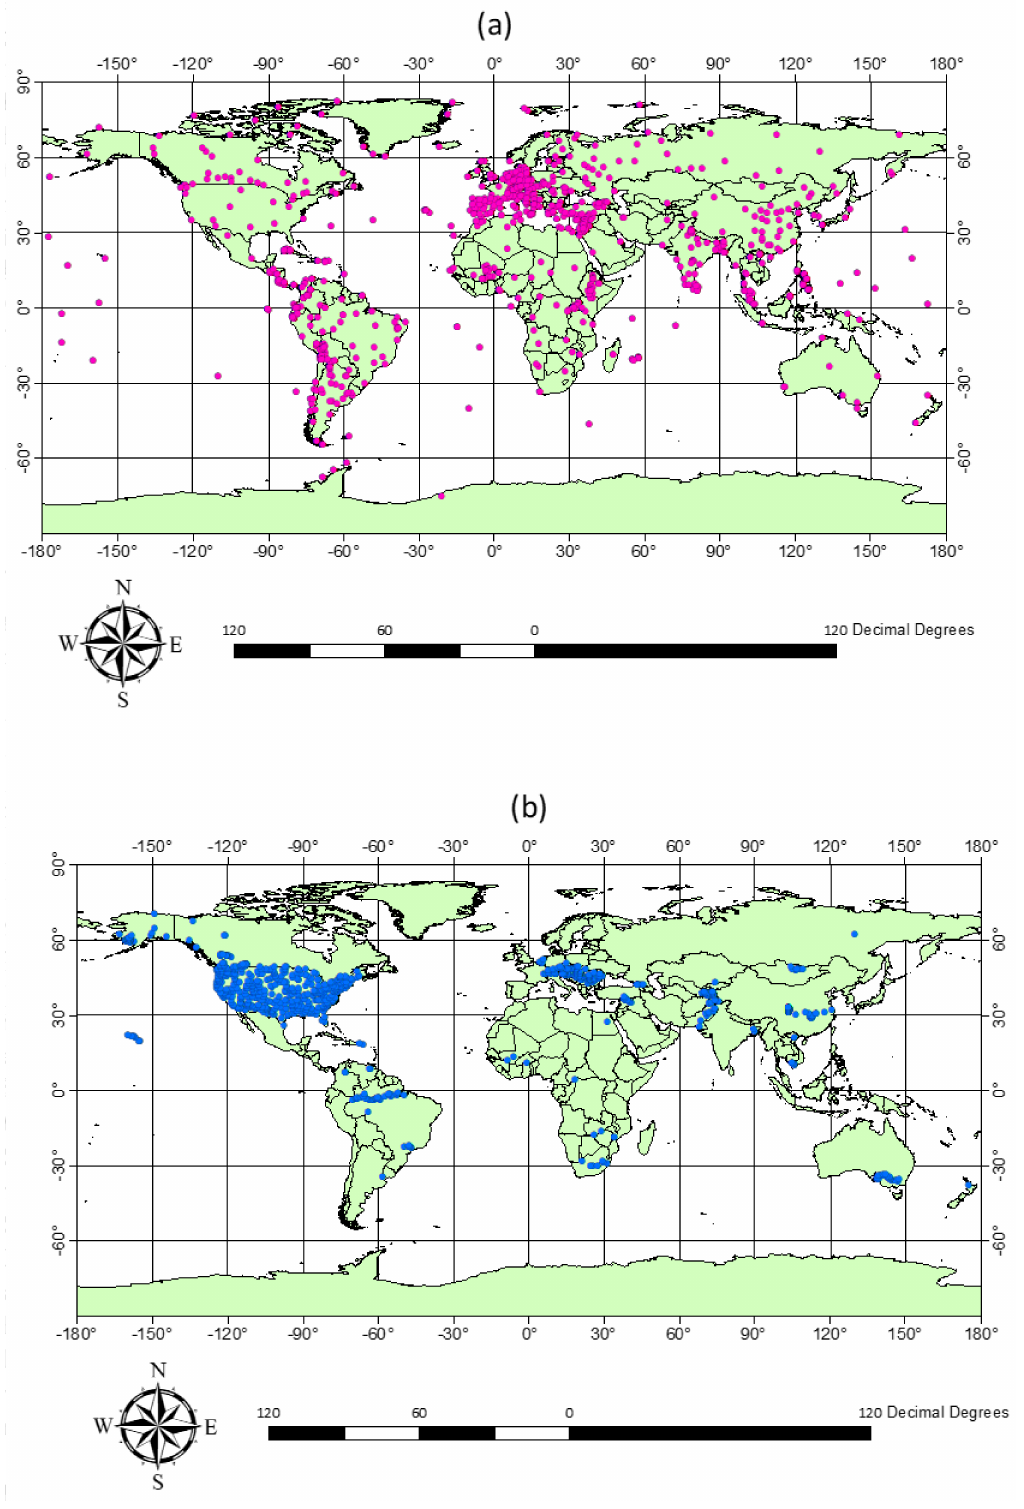
Figure 1. Distribution of data in GNIP ( a ) and GNIR ( b )